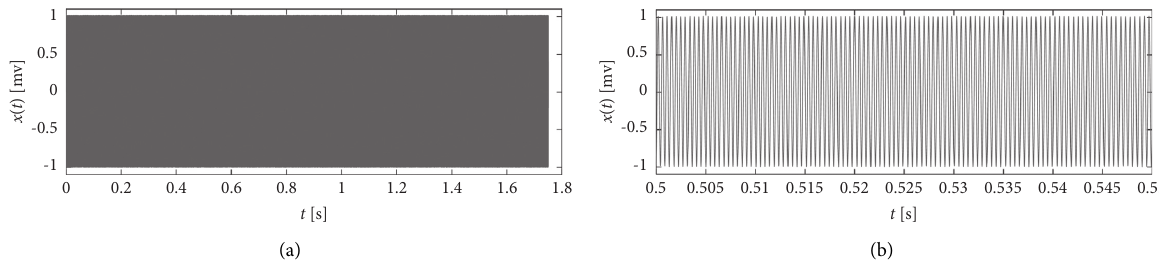
Figure 9: The pulse signal of nontorsional vibration: (a) x ( t ) and (b) the local amplification of x ( t ) .